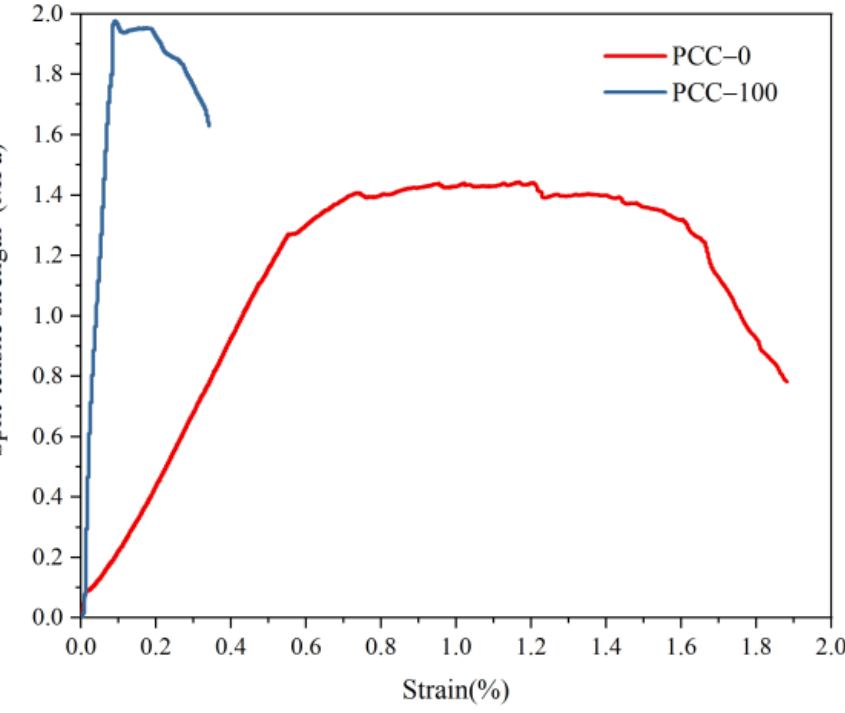
Figure 12. Effect of 3D-printed phase change aggregate on splitting tensile properties of concrete.